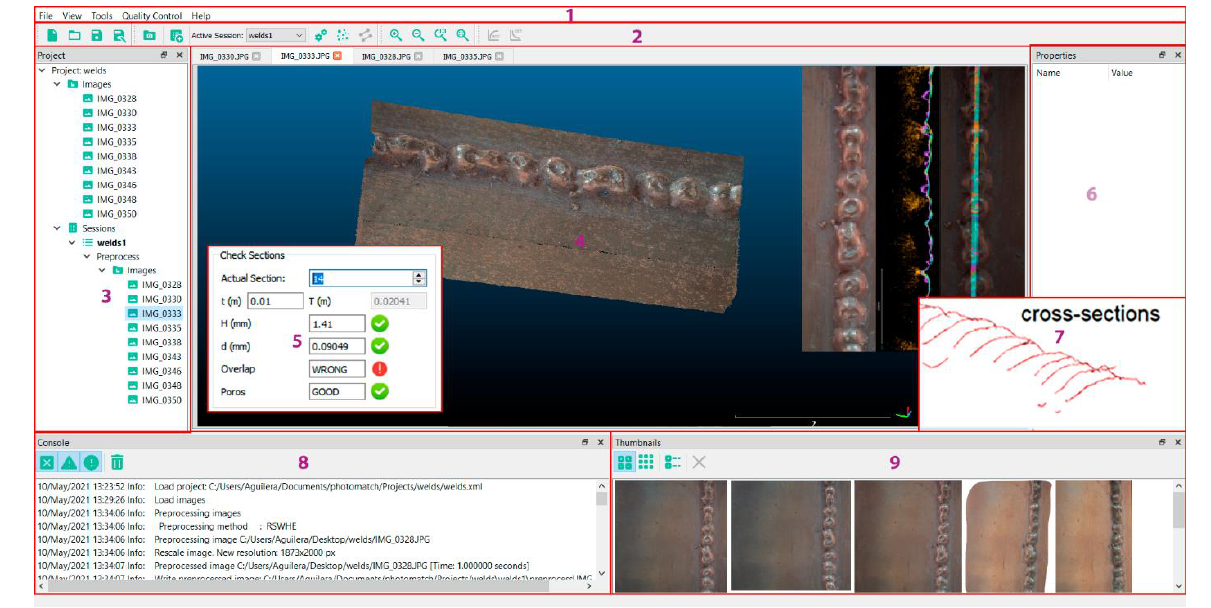
Figure 8. Quality control of welds based on cross-sections and the four defects analysed. In red are highlighted the different parts of the interface: menu (1), toolbar (2), tree view of the different inputs and intermediate results of the projects (3), 3D model viewers (4), pop-up window with the defects analysis (5), property view (6), pop-up window with the cross-sections generated (7), console (8), and thumbnails (9). Table 2. Results of the four defects assessed in WELDMAP software. In red colour are highlighted those defects which did not pass the threshold established. Only those cross-sections which produced defects are reported in the table. T is the width of the bead, t is the width of the weld, n l and n r the normal vectors of the right and left plaques, respectively.